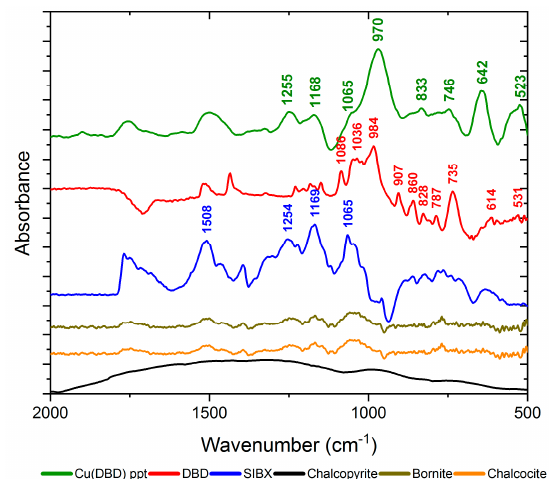
Figure 16. The DRIFT spectra of xanthate, dithiophosphate and copper dithiophosphate precipitates.